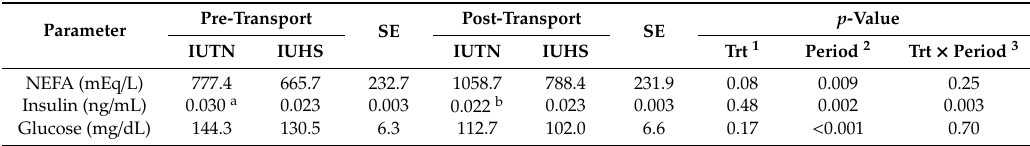
Table 2. Least squares means of circulating concentrations of NEFA (non-esterified fatty acids), insulin and glucose.